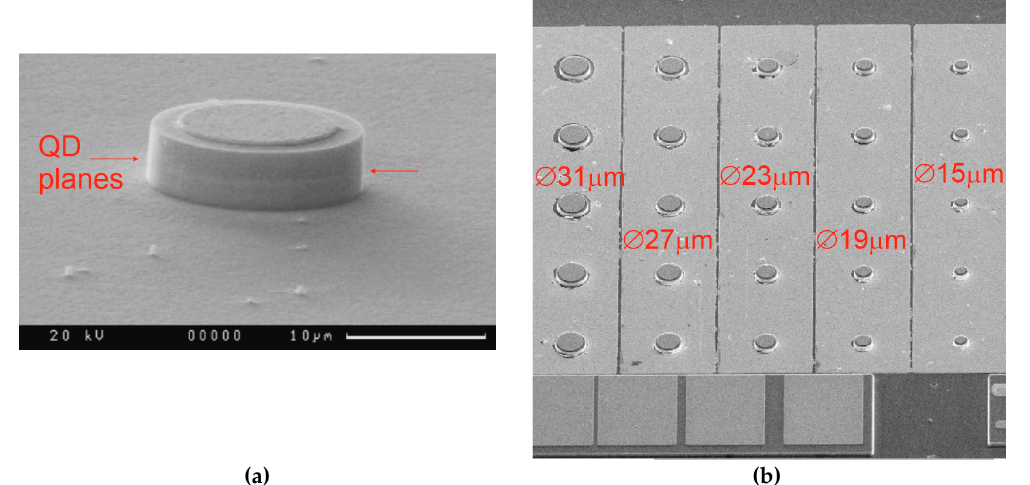
Figure 2. Scanning electron microscopy images of a microdisk with a diameter of 15 µm ( a ) and arrays of microdisks of different diameters ( b ) made on Si substrate.